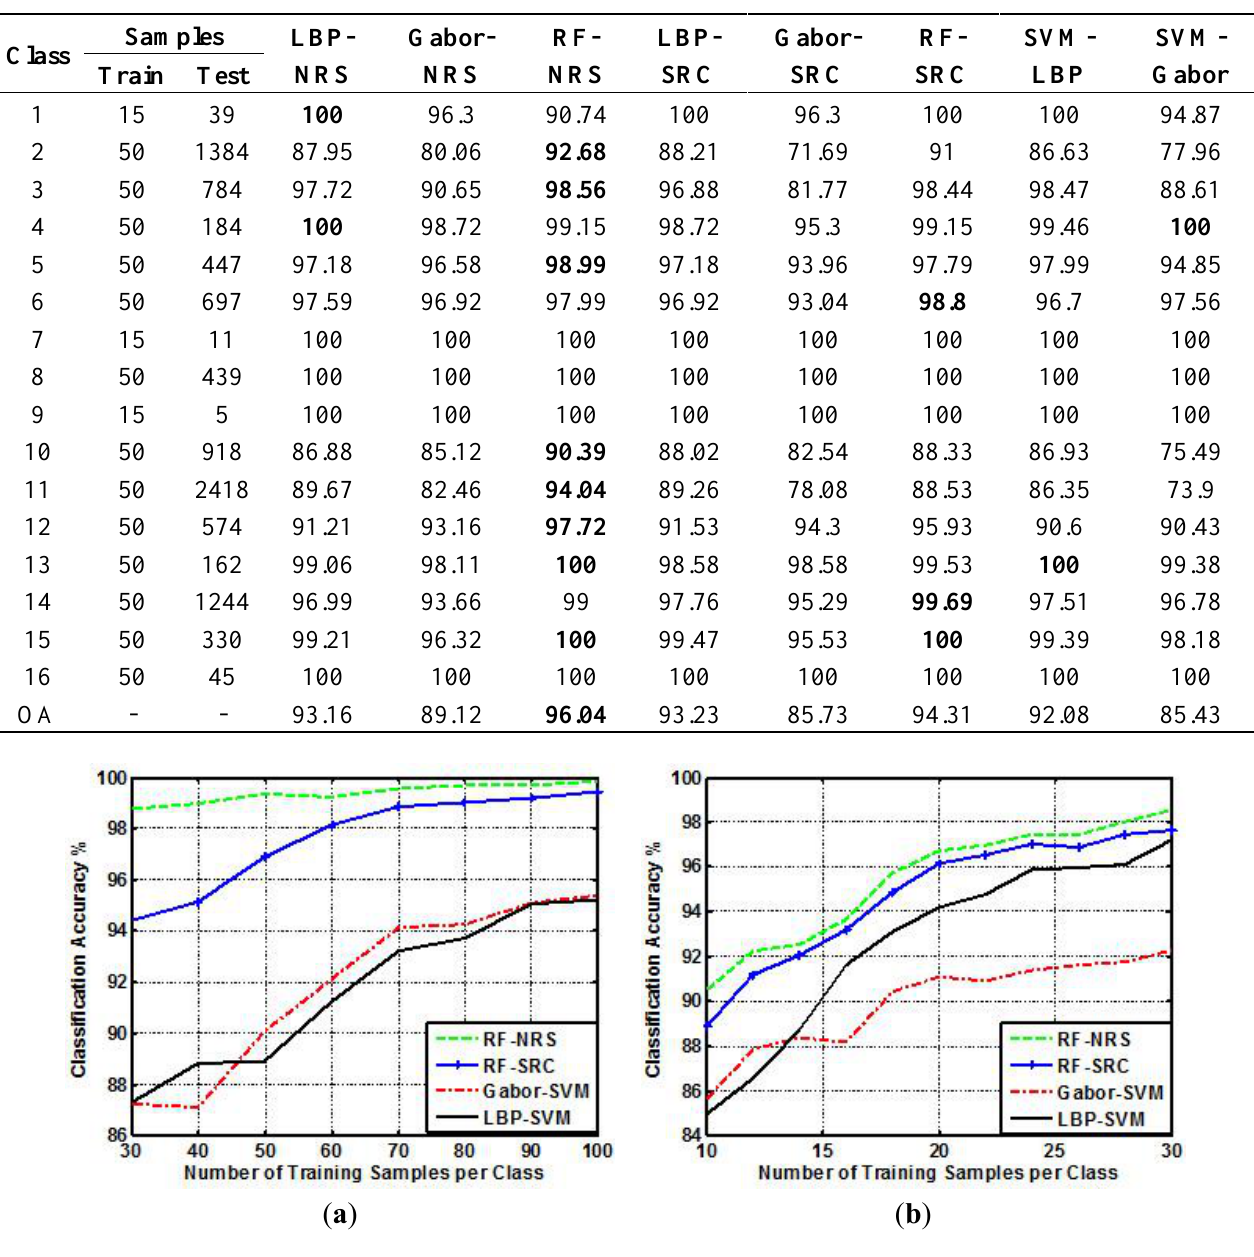
Table 9. Classification accuracy (%) for the Indian Pine dataset.